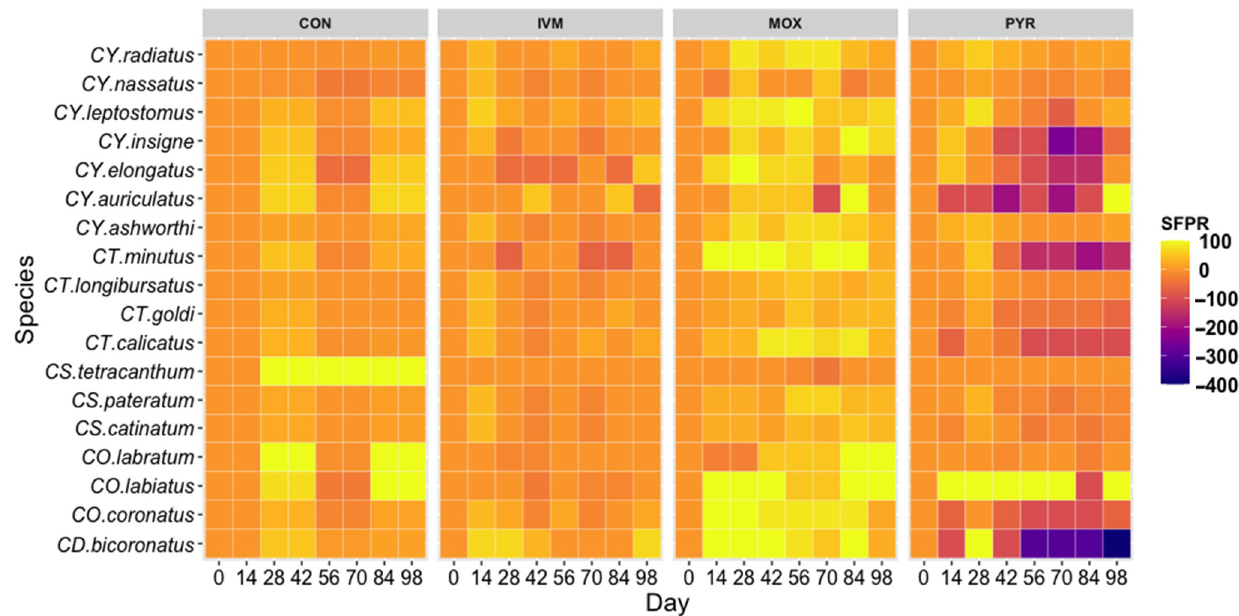
Figure 1. Heatmap of cyathostomin SPFR to anthelmintic treatments. SFPR demonstrates the natural variation of species populations in the CON group and how the species, in turn, respond to anthelmintic treatment. CON-control, IVM-Ivermectin, MOX-Moxidectin, PYR-Pyrantel.